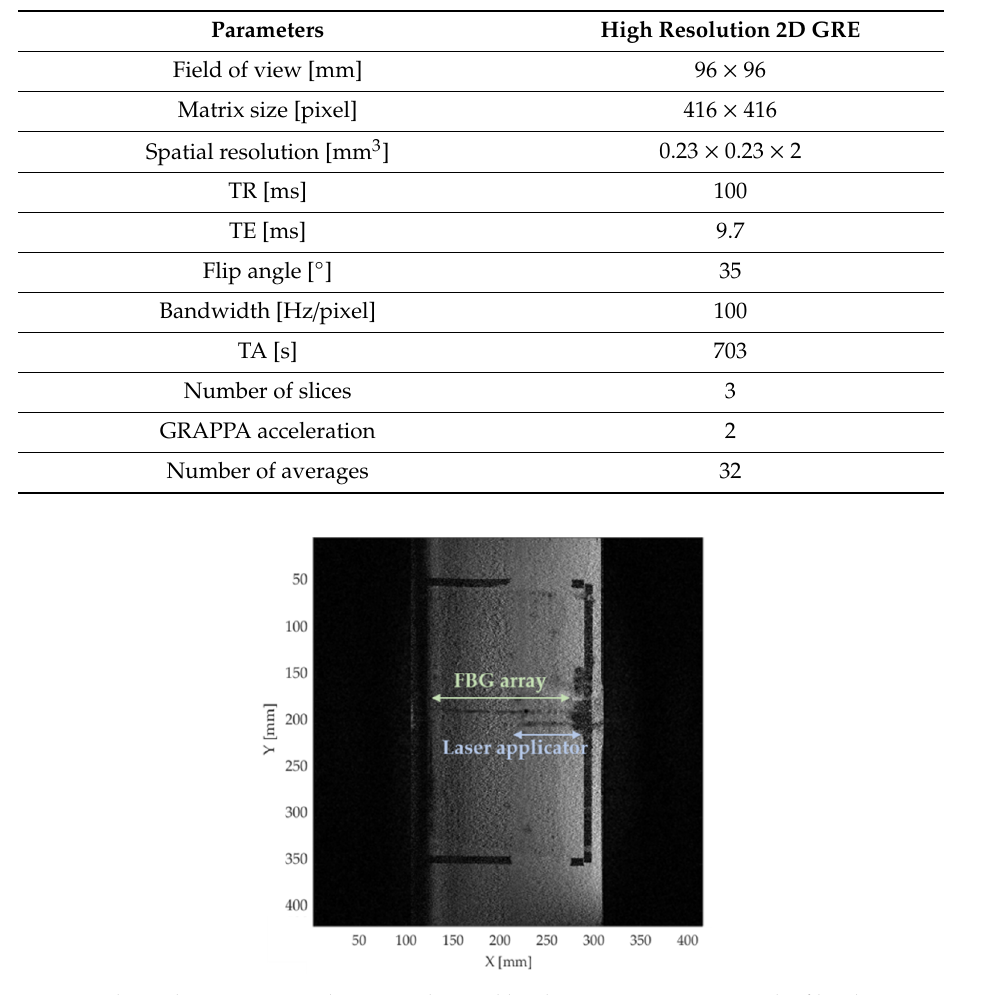
Figure 3. High resolution magnitude image obtained by the 2D GRE sequence. The fiber housing FBG is detectable thanks to a 0.23 × 0.23 mm 2 in-plane resolution and the high SNR. Both the sensing fiber and the laser are visible on the same image.